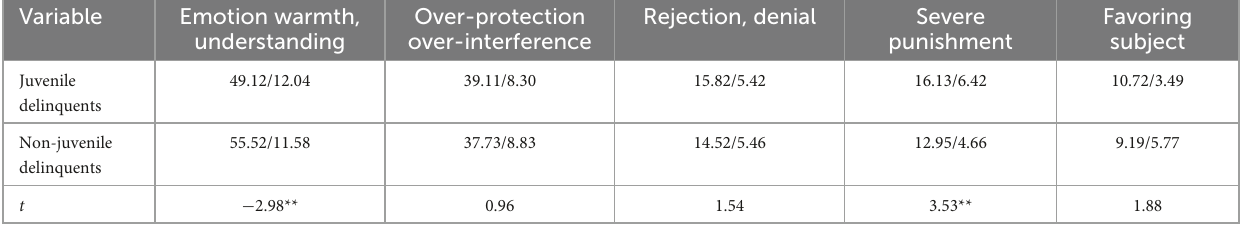
TABLE 4 Comparison of differences in different dimensions between the family rearing styles of juvenile delinquents and non- juvenile delinquents (mother) (M ± SD, n = 112).